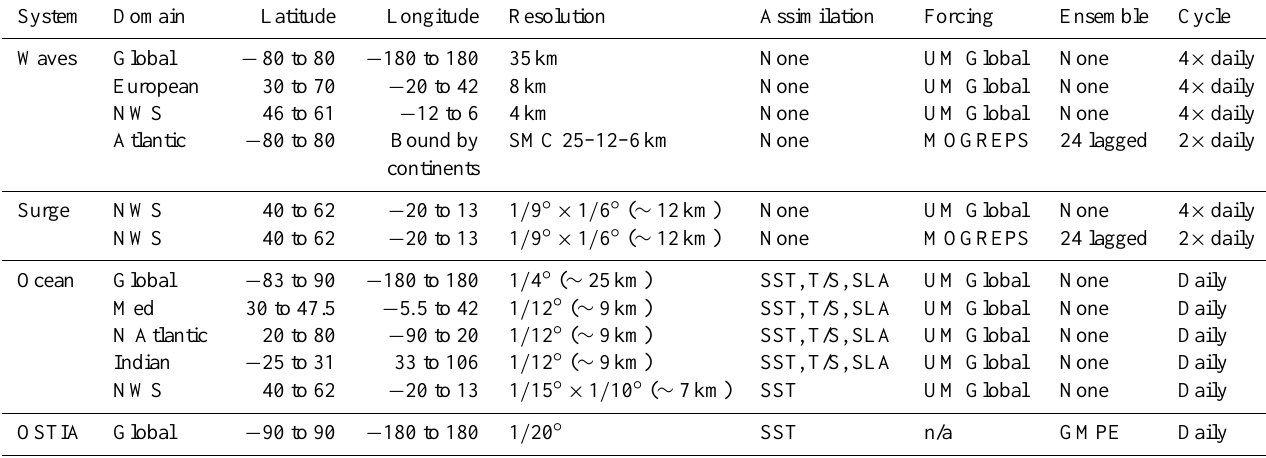
Table 1. The main Met Office marine analysis and prediction systems and their key characteristics. Please refer to the text for details. System Domain Latitude Longitude